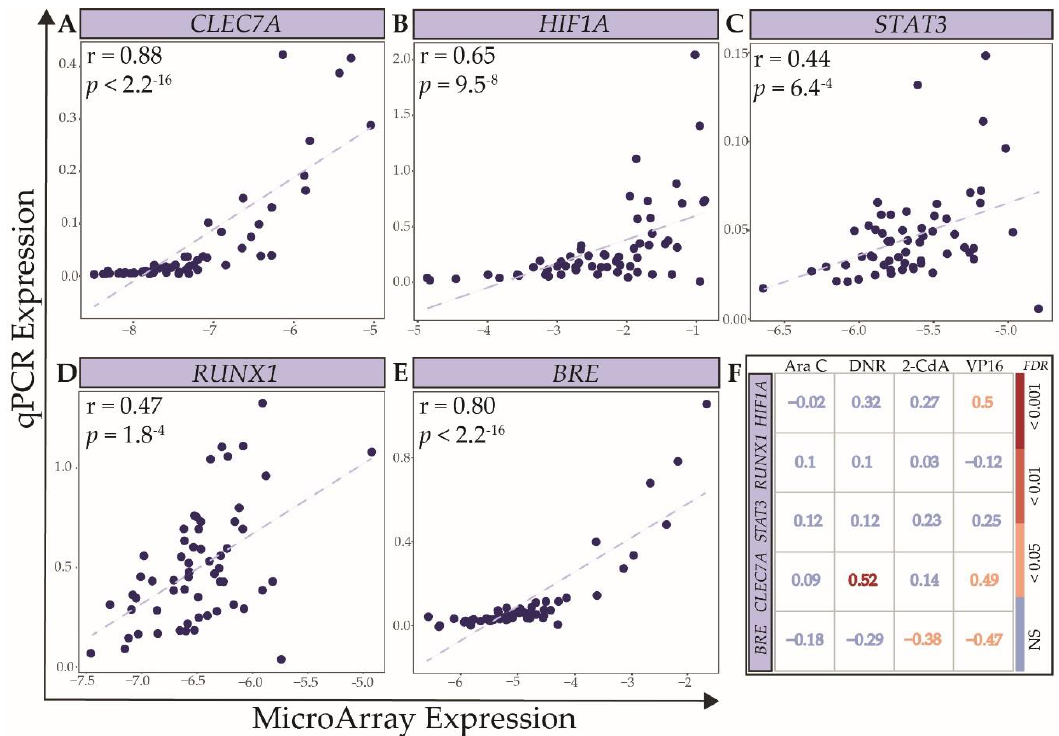
Figure 6. Technical validation of gene expression levels of selected genes. Scatter plots of gene expression levels measured by microarray and qPCR for: ( A ) CLEC7A , ( B ) HIF1A , ( C ) STAT3 , ( D ) RUNX1 , and ( E ) BRE . Correlation coefficients and p -values are calculated using the Spearman’s rank correlation. ( F ) The Spearman’s rank correlation coefficients and FDRs between LC 50 of Ara C, DNR, 2-CdA, and VP16 and expression levels of the abovementioned genes, measured by qPCR in the discovery cohort.